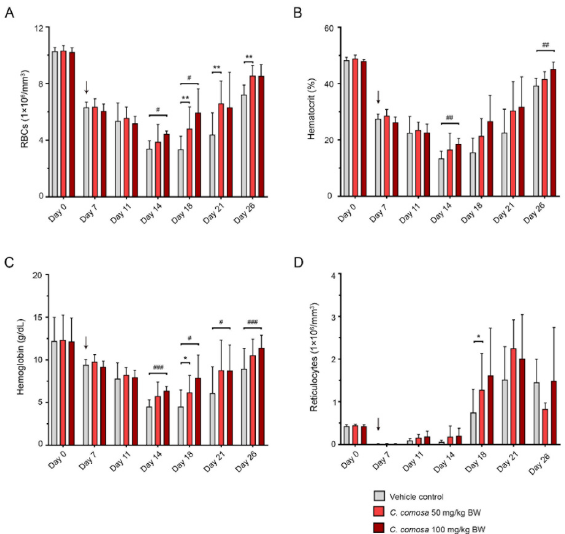
Figure 1. Curcuma comosa accelerated recovery from anemia. Erythropoietic response of mice to sublethal irradiation-induced anemia: ( A ) RBC counts, ( B ) hematocrit level, ( C ) hemoglobin level, and ( D ) reticulocyte counts at days 7, 11, 14, 18, 21, and 26. Irradiated mice were intraperitoneally injected with vehicle control or C. comosa (50 or 100 mg/kg BW) each day. The blood sample was collected from the retro ‐ orbital plexus, and hematological parameters were monitored with an MS9 analyzer. All data are expressed as mean ± SEM ( n = 9). * p < 0.05 and ** p < 0.01, ASPP 049 compared with vehicle control treatments (ANOVA); # p < 0.05, ## p < 0.01, and ### p < 0.001, E2 compared with vehicle control treatment (ANOVA). BW, body weight; RBC, red blood cell. Black arrow indicates the induction of anemia.